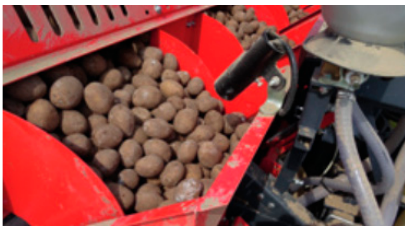
Figure 21. Tipping automat sensor. Reprinted with permission from ref. [80]. Copyright 2021 Dewulf Industries.